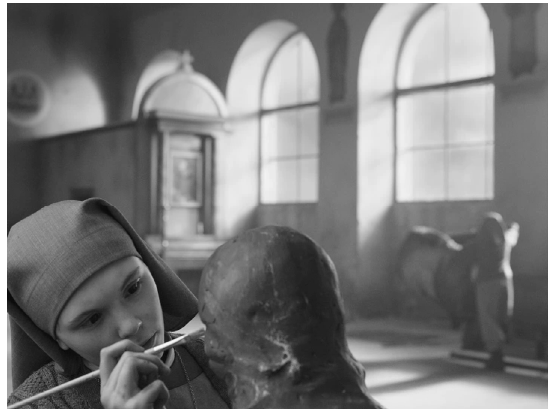
Figure 1. Ida paints a statue of Jesus.